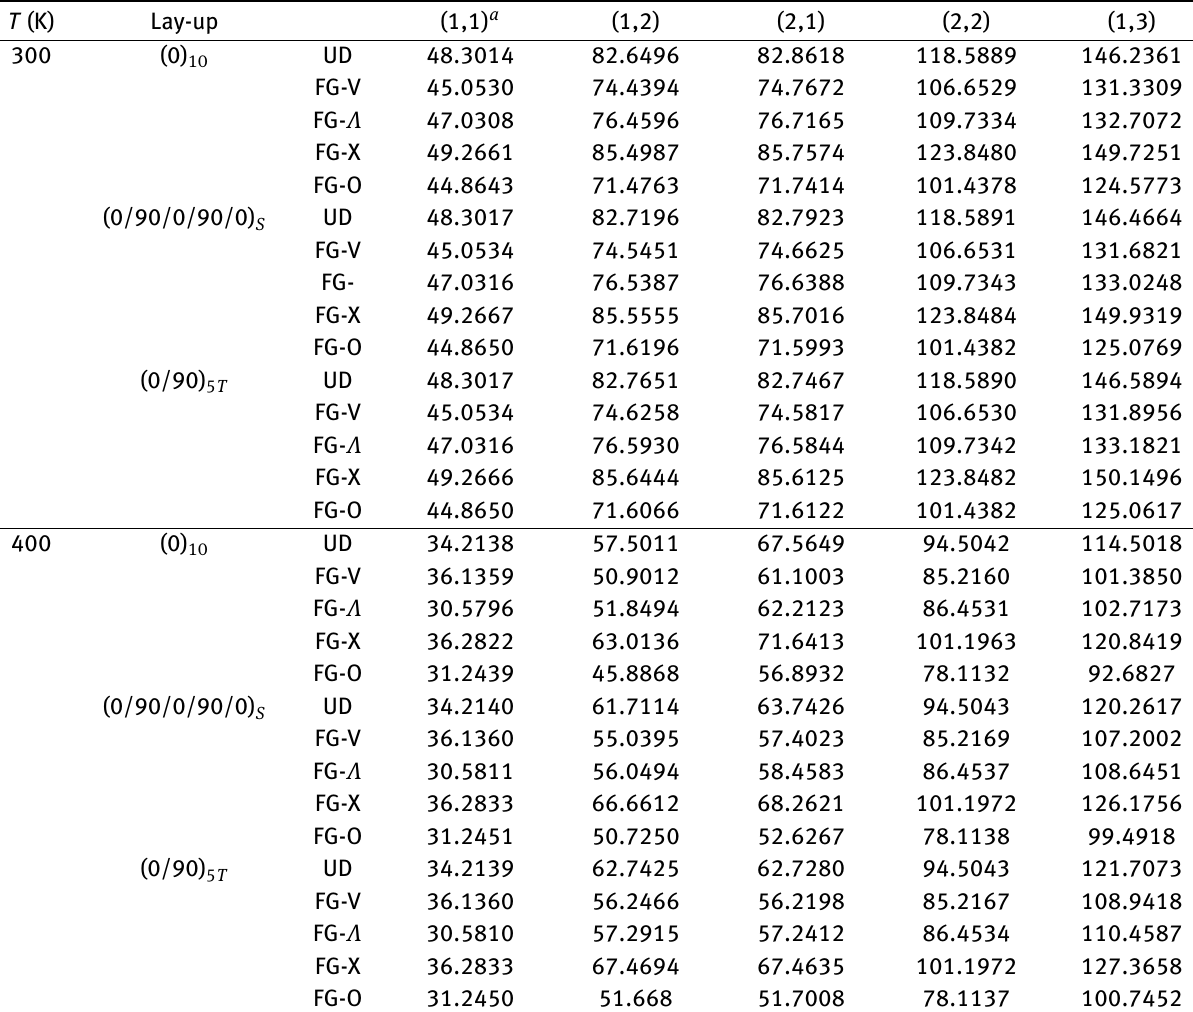
Table 5: Natural frequency ˜ Ω = Ω ( b 2 / h ) √︀ ρ 0 / E 0 of double curved GRC laminated panels in thermal environments ( a/b = 1, b/h = 20, h = 2 mm, a/R 1 = b / R 2 =